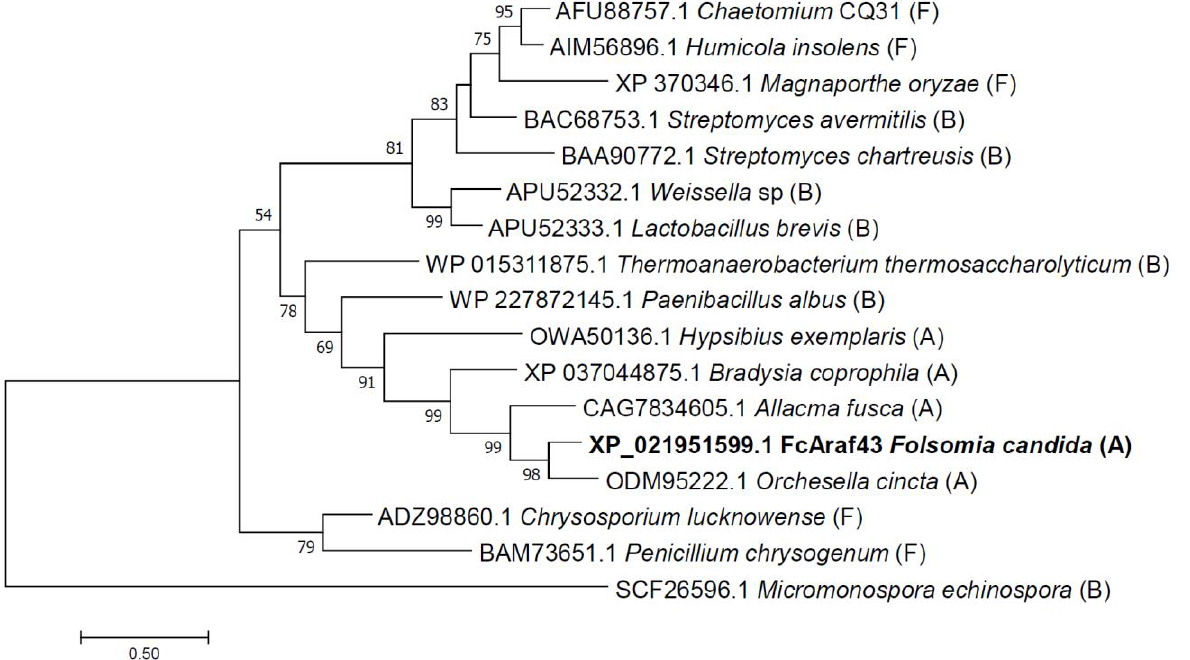
Figure 2. Phylogenetic relation of FcAraf43. An elaborate set of 16 animal, fungal and bacterial peptides from classified CAZy family 43 enzymes were aligned along with FcAraf43. The presented phylogeny is based on maximum likelihood using WAG+G evolutionary model; the outgroup is set at Micromonospora . The numbers next to branches show the percentage bootstrap support based on 1000 replicates. GenBank accession numbers of the annotated CAZy genes are given in front of species names. Branch lengths are measured as the number of substitutions per position/site, with the scale bar representing the length for 0.5 substitutions. Letters in brackets indicate phylum: A, Animal; B, Bacterial, F,